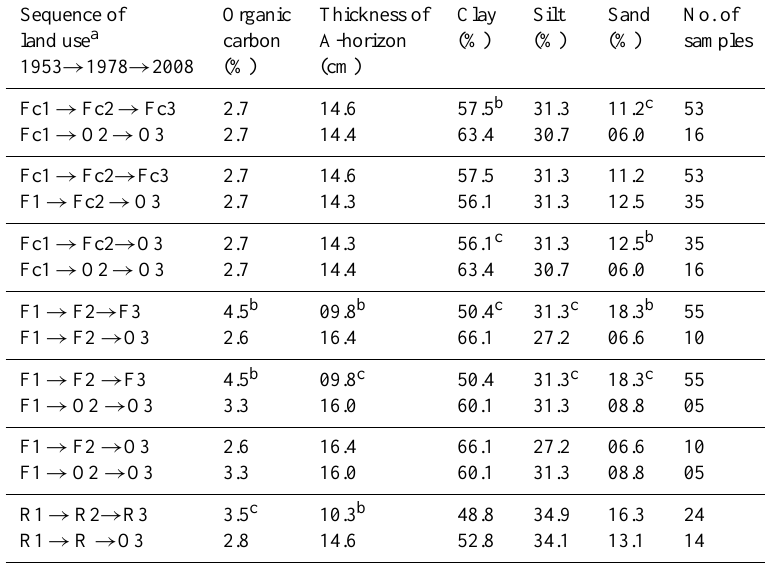
Table 2. Properties of soils subjected to land use changes since 1953. Sequence of Organic Thickness of Clay